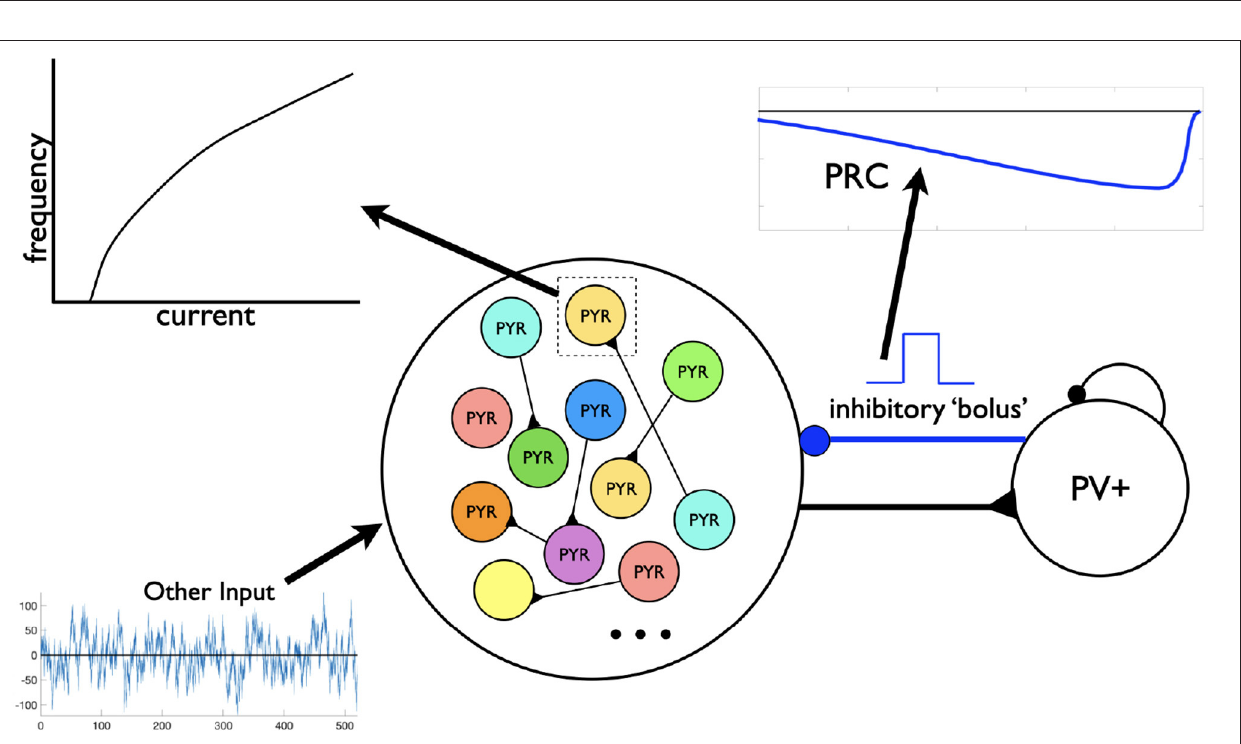
FIGURE 4 | Raster plot outputs of PYR cells from three heterogeneous E-I simulations. These three model sets generating population burst rhythmic output exhibit three different frequencies that we refer to as “slow” (9.6 Hz), “medium” (13 Hz), and “fast” (15 Hz) from their respective model sets. For all three sets, the heterogeneous PYR cells include those with Rheo base values, whereas only the model set producing the “medium” output has PYR cells with SFA base values. Except for the model set producing “slow” output, PYR cells have PIR base values. That is, the triplet [SFA,Rheo,PIR] feature for the slow, medium and fast networks are MMH, HML, and LML, respectively.